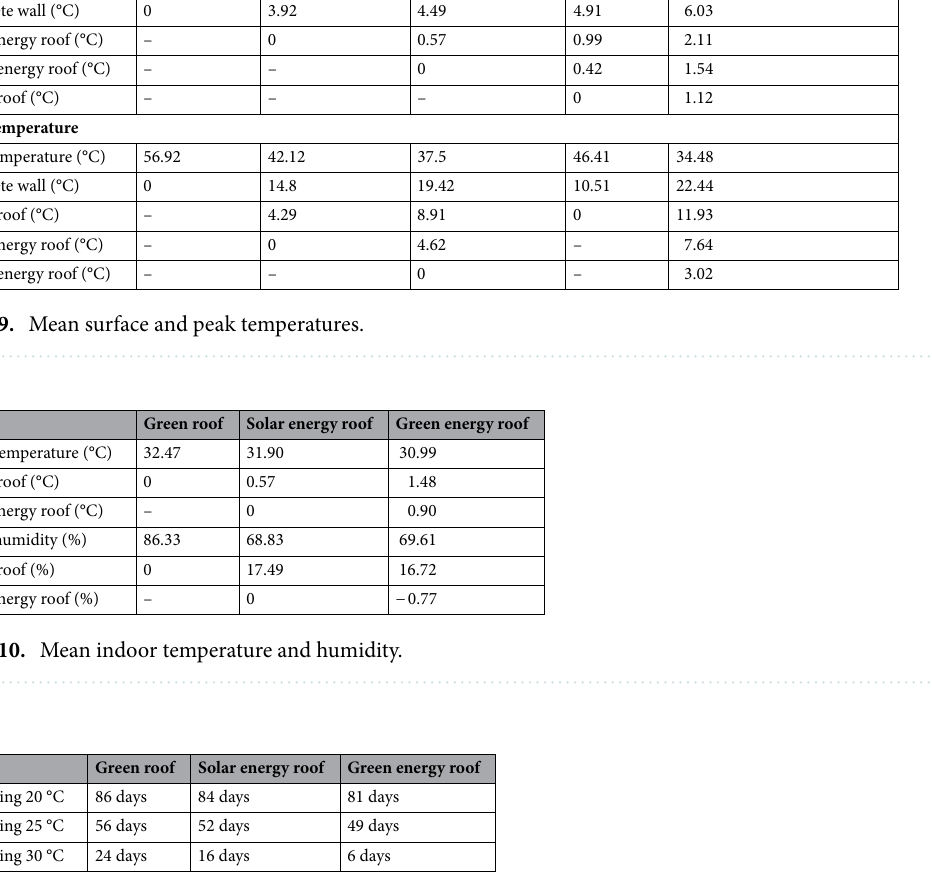
Table 11. Mean indoor temperatures and number of days with high temperatures for the different